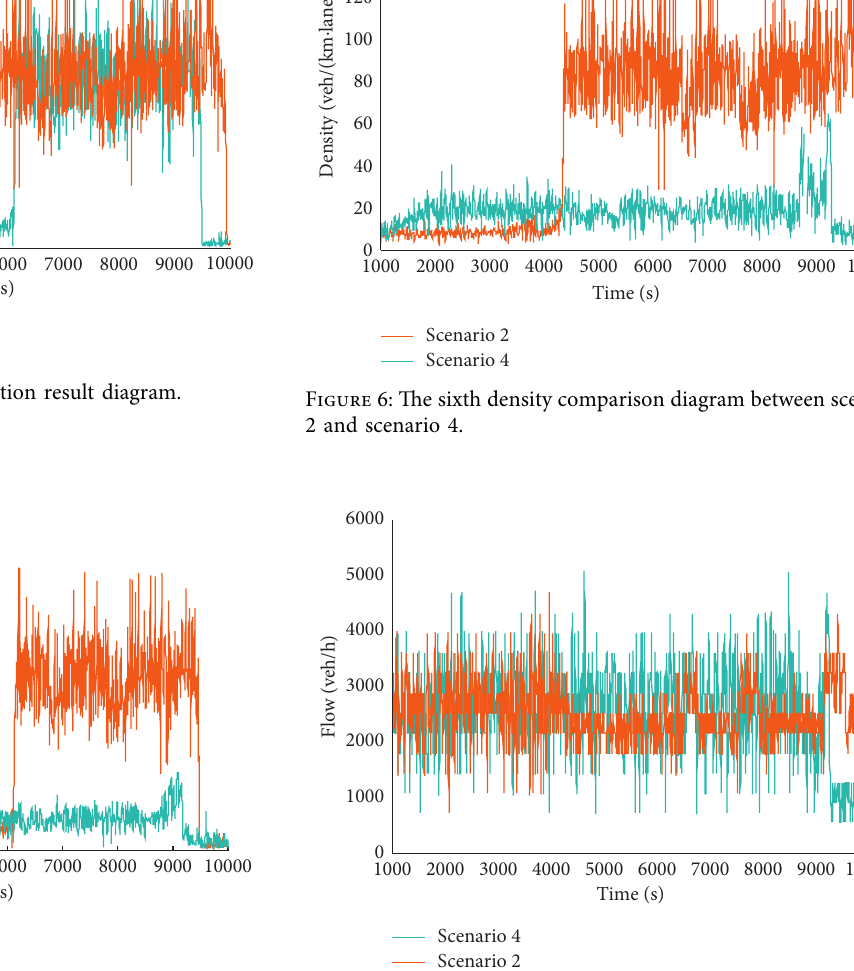
Figure 5: The fifth density comparison diagram between scenario 2 and scenario 4.